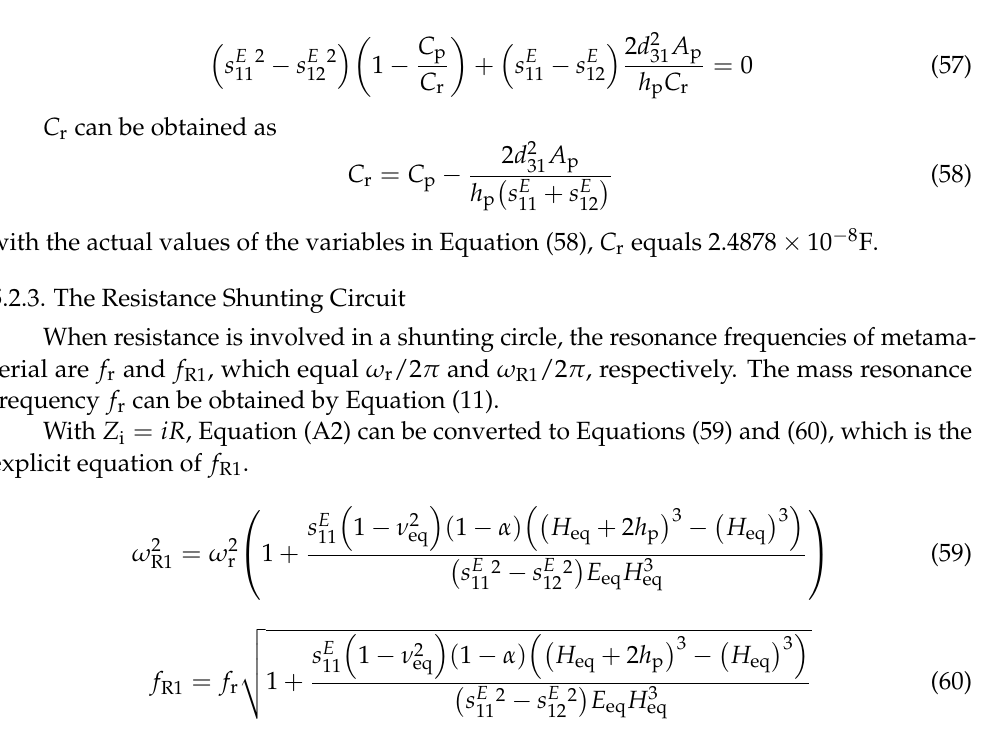
Figure 16. The change of 𝑓 (cid:2887)(cid:2869) with capacitance increasing.